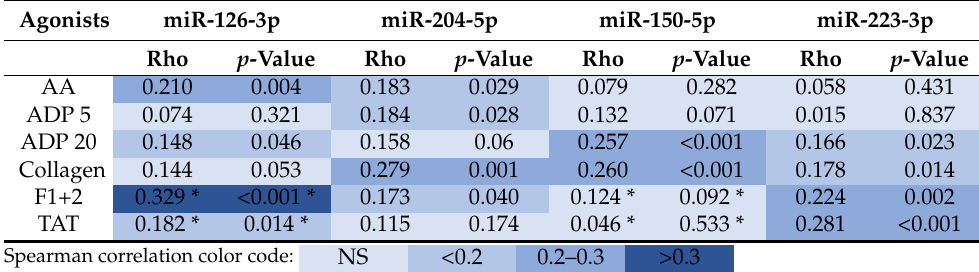
Table 3. Correlations between circulating miRNA levels and platelet aggregation and thrombin generation markers in stable cardiovascular patients. * The association between miR-126-3p and miR- 150-5p with thrombin generation markers are derived from Zapilko et al. [17]. AA: arachidonic acid; ADP 5: adenosine diphosphate 5 µ M; ADP 20: adenosine diphosphate 20 µ M; F1+2: